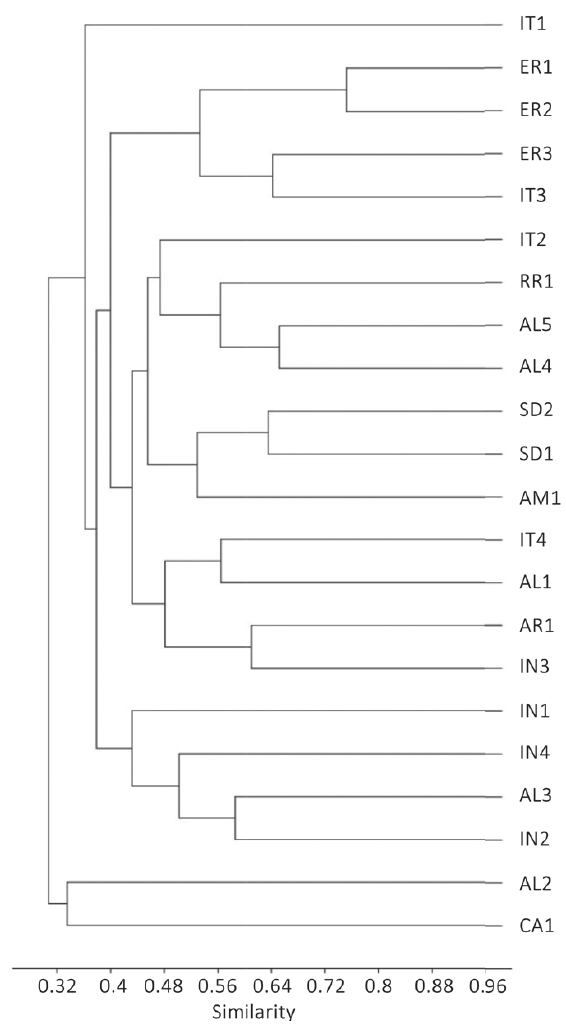
Figure 4 - Similarity (Jaccard coeffi cient) between propolis samples produced in municipalities from the territory of the Agreste of Alagoinhas. Formation of six clades (A-F) according to pollen similarity.